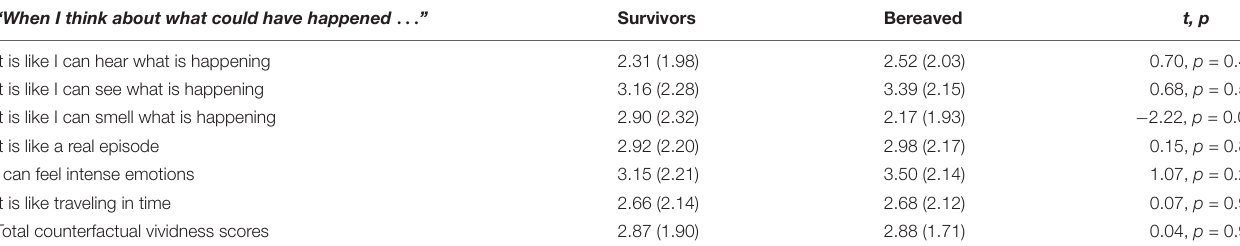
TABLE 2 | Mean scores on the counterfactual vividness items with standard deviations in parentheses. “When I think about what could have happened ...